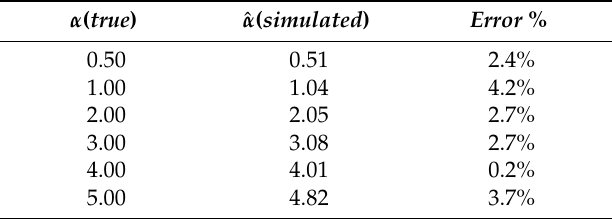
Table 3. Simulation results with κ = 0.00003, J = 1.3 J th